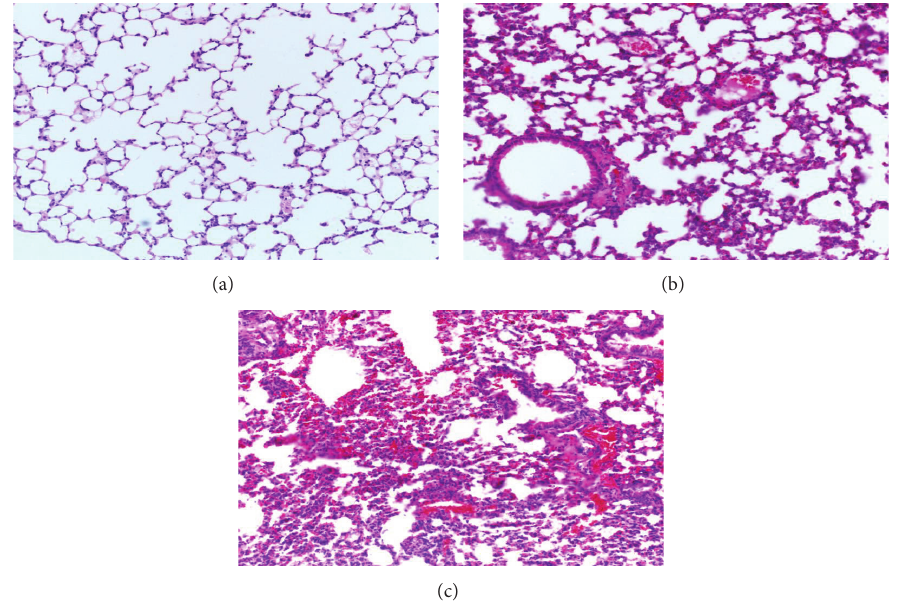
Figure 2: Representative H&E sections of pulmonary tissues (magnification, 100x). After treatment, the sham group (a) had no obvious inflammation; the fracture group (b) and the fracture plus surgery group (c) showed typical symptoms of acute lung